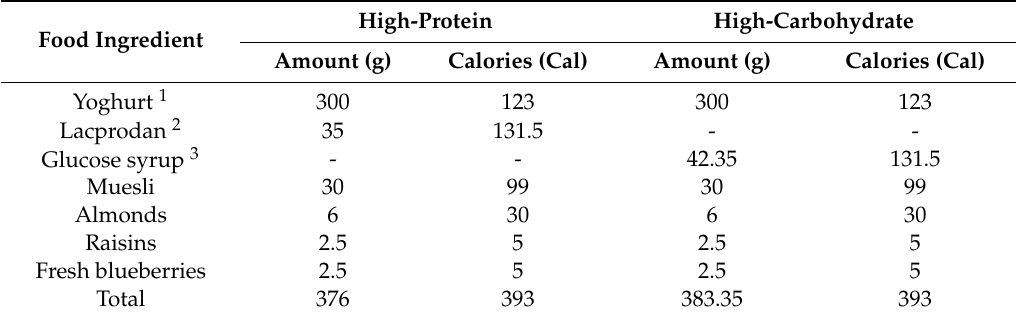
Table 2. Content of the two test meals: High-protein breakfast and High-carbohydrate breakfast. Food